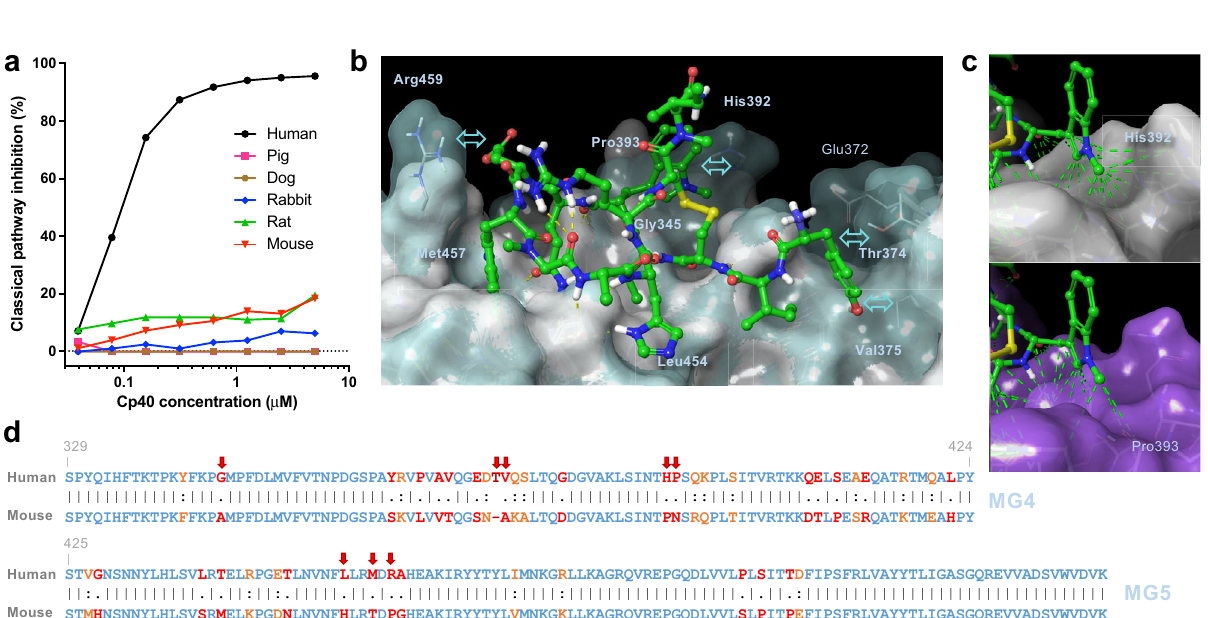
associated to the integral calculation of each peak in the binding isotherm (as determined by AFFINImeter). Cp05* contains the linker necessary for the con- jugation to PEG-40kDa; its binding pro fi le is comparable to that of Cp05 (Supple- mentaryFig.10c). c SPRanalysisbetweenimmobilizedC3bandmono-andbivalent Cp05 analogs reveal a strong enhancement of surface binding for Cp05-PEG-Cp05 over monovalent Cp05. d Isoaf fi nity kinetic plot for surface interactions of comp- statin analogs with immobilized C3b, demonstrating that the development steps fromCp01toCp40wereenabledbyimprovingdissociationrateswithlittleimpact on association rates. In contrast, the improved stability of the C3b complex with Cp05-PEG-Cp05 is accompanied by a marked drop in the association rate. PEG polyethylene glycol, RU resonance units.